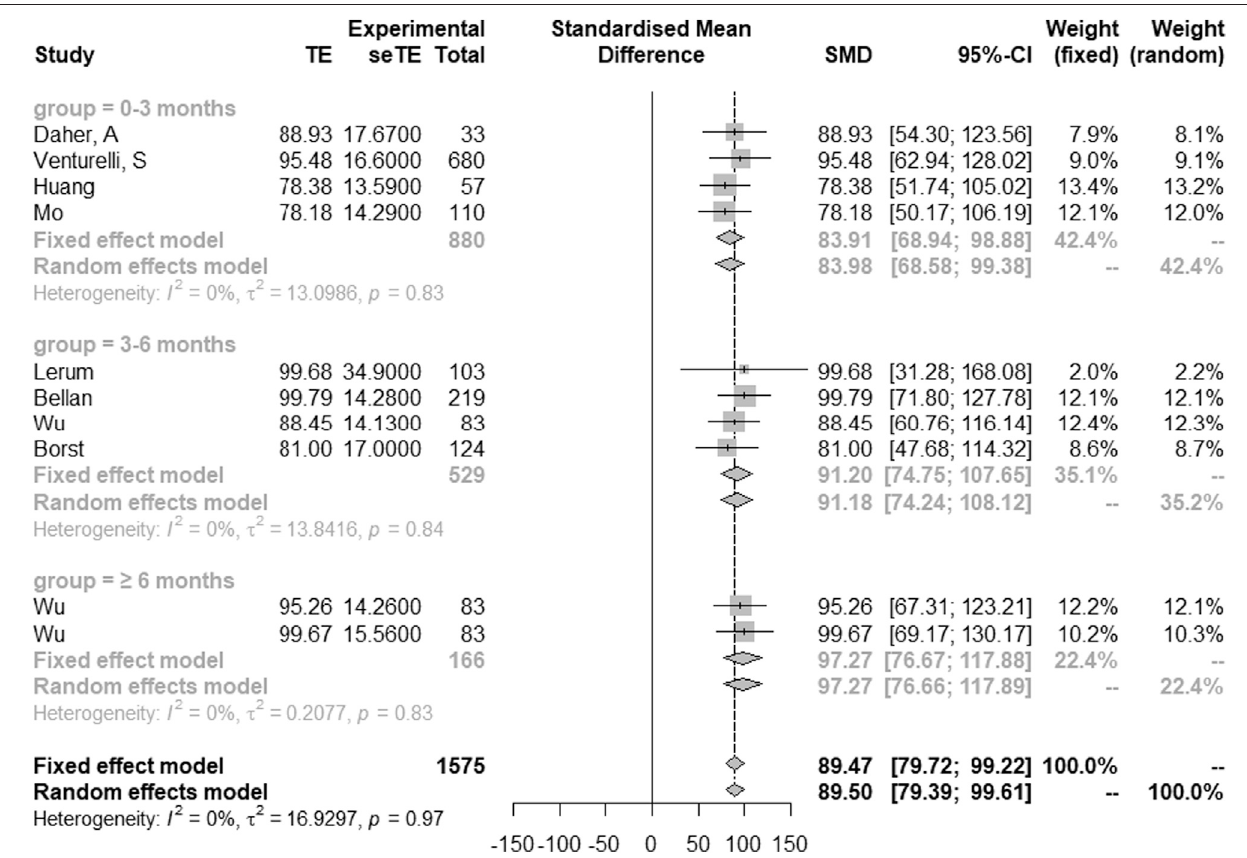
FIGURE 4 | Comparison of longitudinal changes in DLCO (% of predicted). Forest plot showing meta-analysis of DLCO (% of predicted).